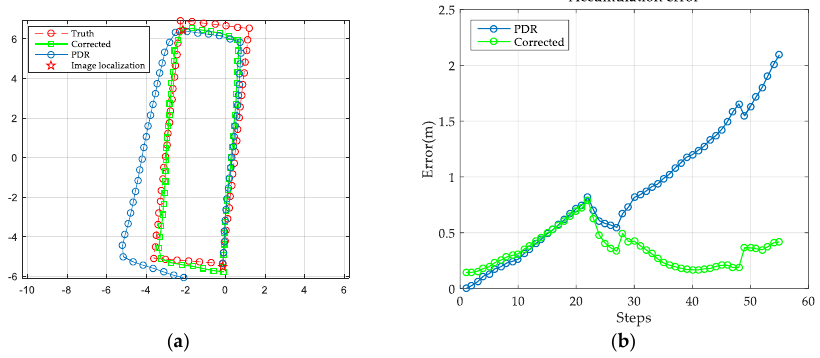
Figure 11. Map-constrained trajectory estimation: ( a ) is the map-constrained result of the trajectory estimation; ( b ) is the accumulative error.